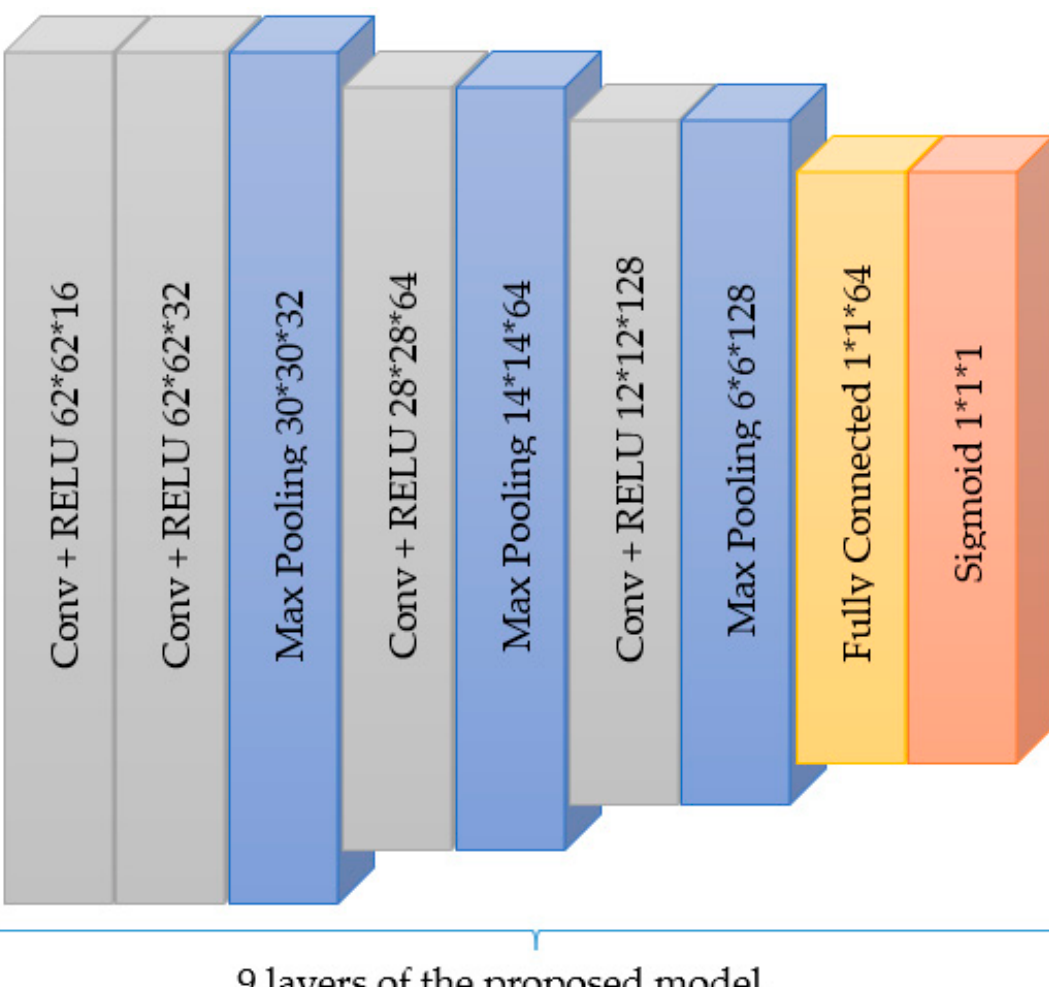
Figure 2. The basic architecture of the proposed model.